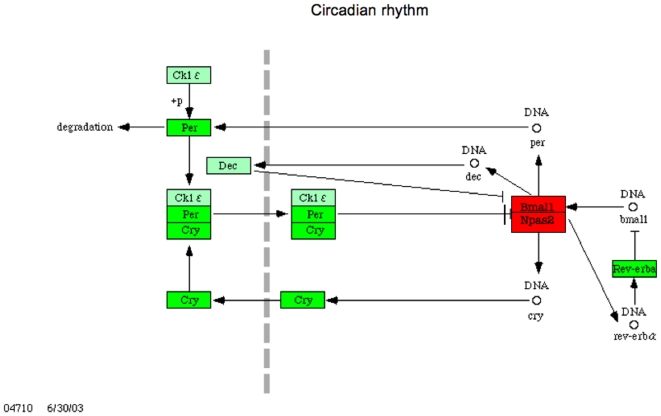
Circadian rhythm genes differentially expressed in tumour shown with KEGG PATHWAYS (modified from Kanehisa et al., 2008) (P<0.05).CRY2, PER1, PER3 and NR1D1/Rev-Erb alpha that function as negative regulators of transcription are down-regulated (green) whereas both genes encoding the active transcriptional heterodimeric complex Bmal1(ARNTL):Npas2 (NPAS2) are overexpressed in mesothelioma versus normal parietal pleura. Damaged circadian rhythms may be a key to the continuous replicative force in tumour cells, and thus possible treatment targets.